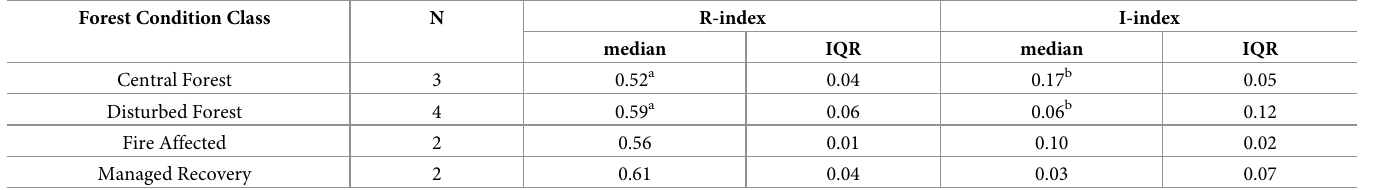
Fig 3. Rock-Eval indices for disturbed sites: a) I/R diagram; b) boxplots of R-index values for peat profile layers; c) boxplots of I-index values for peat profile layers. https://doi.org/10.1371/journal.pone.0280187.g003 Based on the Rock-Eval I- and R- indices the effects of peat core location and disturbance were assessed between the different depth layers in the peat profiles. For the upper 50 cm of the peat profile, R-index and I-index values were found to be significantly different among locations (R-index: Kruskal-Wallis chi-squared = 11.196, d.f. = 3, p-value = < 0.05; I-index: Kruskal-Wallis chi-squared = 10.693, d.f. = 3, p-value = < 0.05)(Table 3). A significant differ- ence in R-index and I-index values were found between Central Forest locations and disturbed sites (R-index: W = 11, d.f. = 1, p-value = < 0.001; I-index: W = 115, d.f. = 1, p-value = < 0.001) (Table 4). For the combined below water table and deeper sections of the peat profile, R-index and I- index values were found to be significantly different between locations (R-index: Kruskal-Wal- lis chi-squared = 12.79, d.f. = 3, p-value = < 0.001; I-index: Kruskal-Wallis chi-squared = 13.907, d.f. = 3, p-value = < 0.001) (Table 5). No significant difference in R-index and I-index values were found between Central Forest locations and disturbed sites. Table 3. R- and I- index median and interquartile range (IQR) for upper 50 cm section in the peat profile for the four forest condition classes. Significant pairwise Wilcoxon tests with Bonferroni adjustments share the same subscript letter. © University of Nottingham/ British Geological Survey © UKRI. Forest Condition Class N